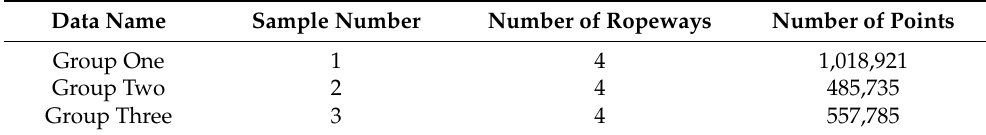
Table 2. The basic situation of each group of test sample